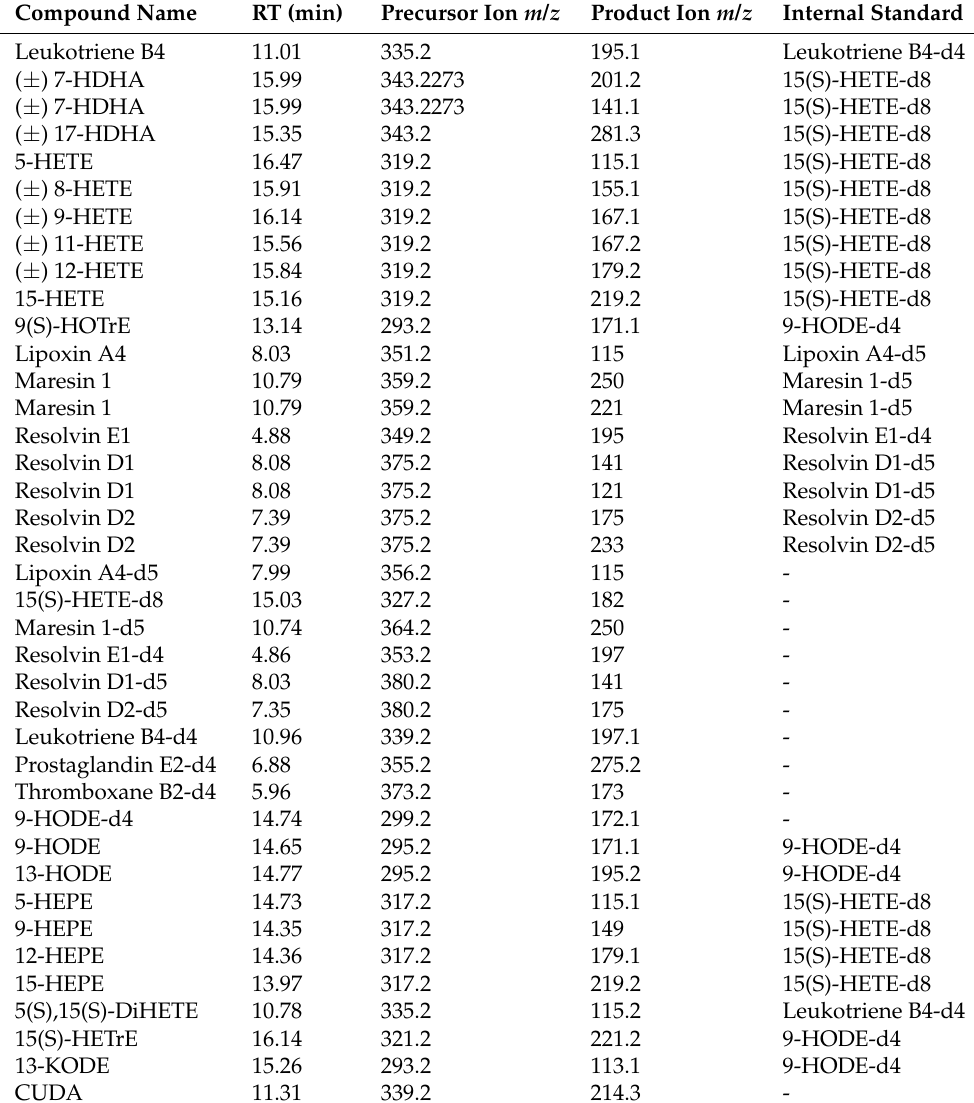
Table A2. Library of 52 targeted oxylipins with their corresponding retention time, product and metabolite m / z , and deuterated internal standard used for